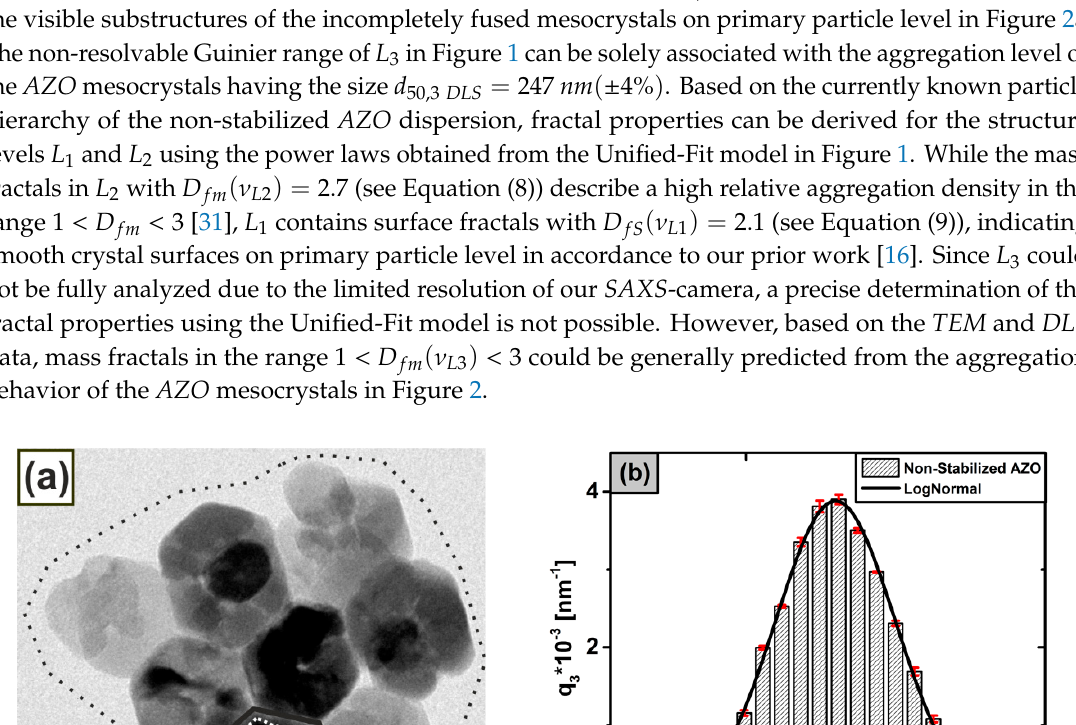
5 of 13 Figure 1. (cid:1845)(cid:1827)(cid:1850)(cid:1845) curve of a non-stabilized (cid:1827)(cid:1852)(cid:1841) dispersion in ethanol (black dots) including the local